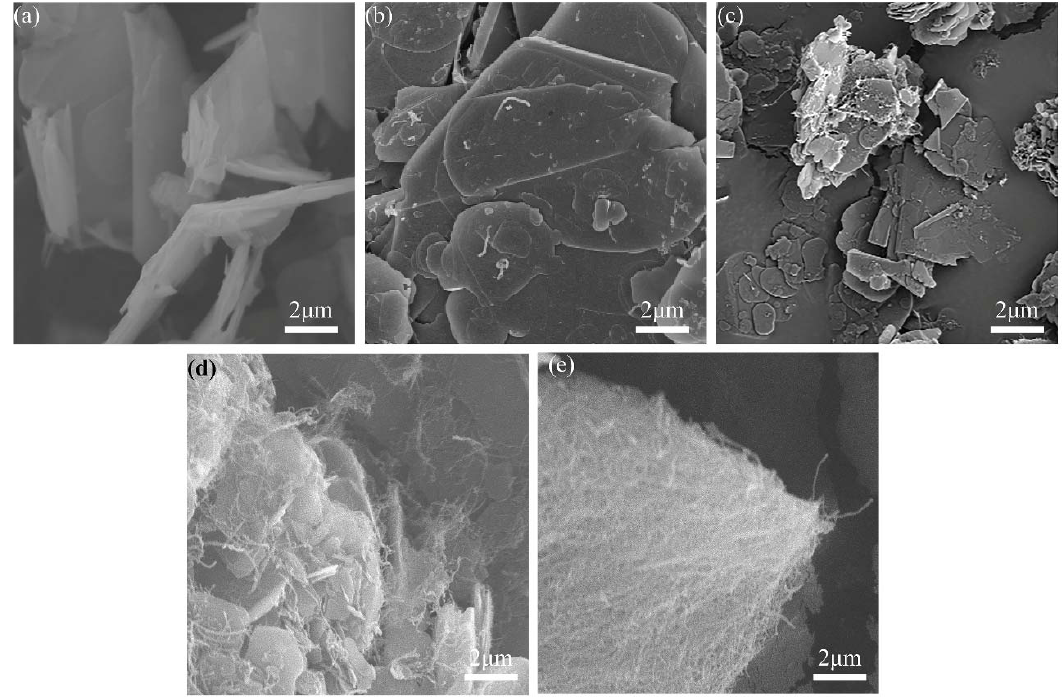
Figure 4. SEM image of BN@xCNT hybrid fillers of ( a ) pristine h ‐ BN;( b ) BN@5CNT; ( c ) BN@10CNT;